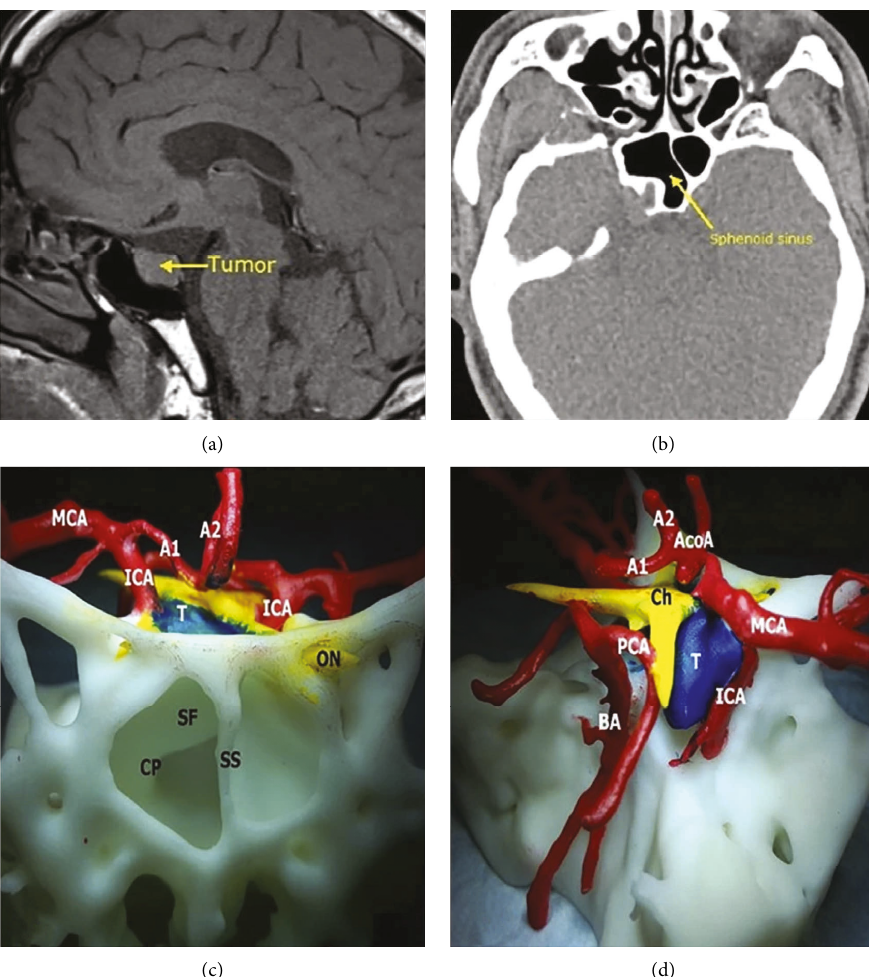
Figure 2: (a) MRI of the sella turcica region showing tumor lesions. The yellow arrow points to the tumor. (b) CTof the sphenoidal sinus. The yellow arrow points to the sphenoidal sinus. (c, d) Frontal and lateral views. SF, sellar floor; SS, sphenoid septation; CP, carotid protuberance; A1, A1 segment of the anterior cerebral artery; BA, basilar artery; PCA, posterior cerebral artery; A2, A2 segment of the anterior cerebral artery; Ch, chiasm; T, tumor; ON, optic nerve; AcoA, anterior communicating artery; MCA, middle cerebral artery; reprinted with permission under open access from Huang et al.